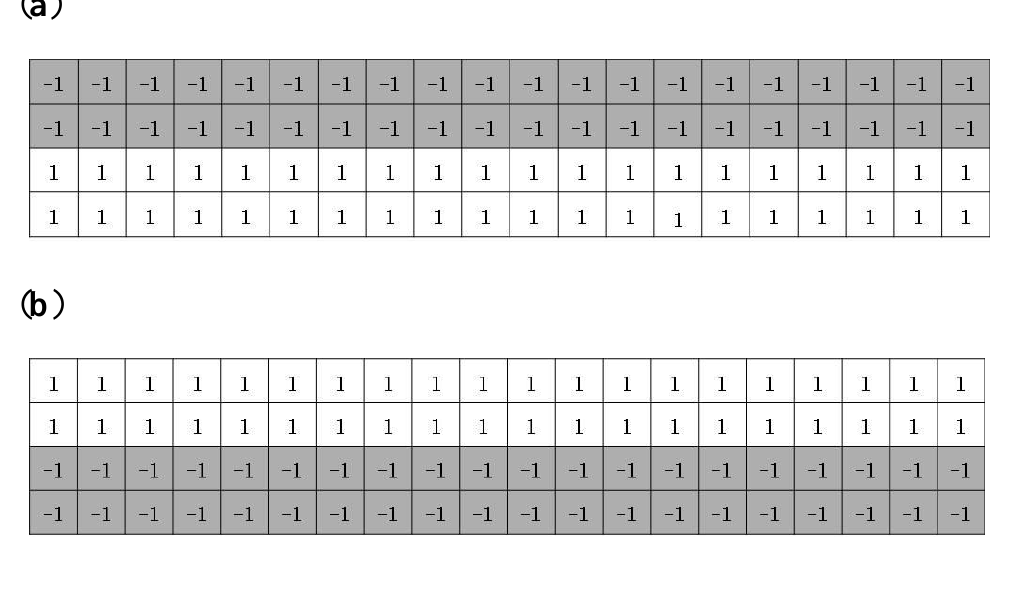
Figure 3. Examples of finger region detection using images from database